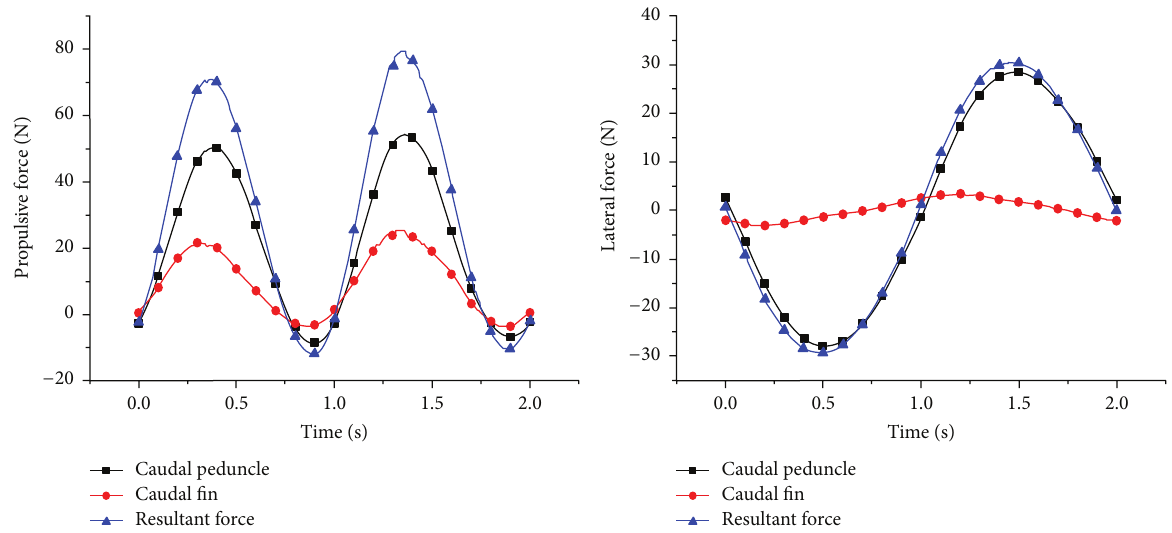
Caudal peduncle Caudal fin Resultant force Figure 8: Hydrodynamic curves for the optimal parameters